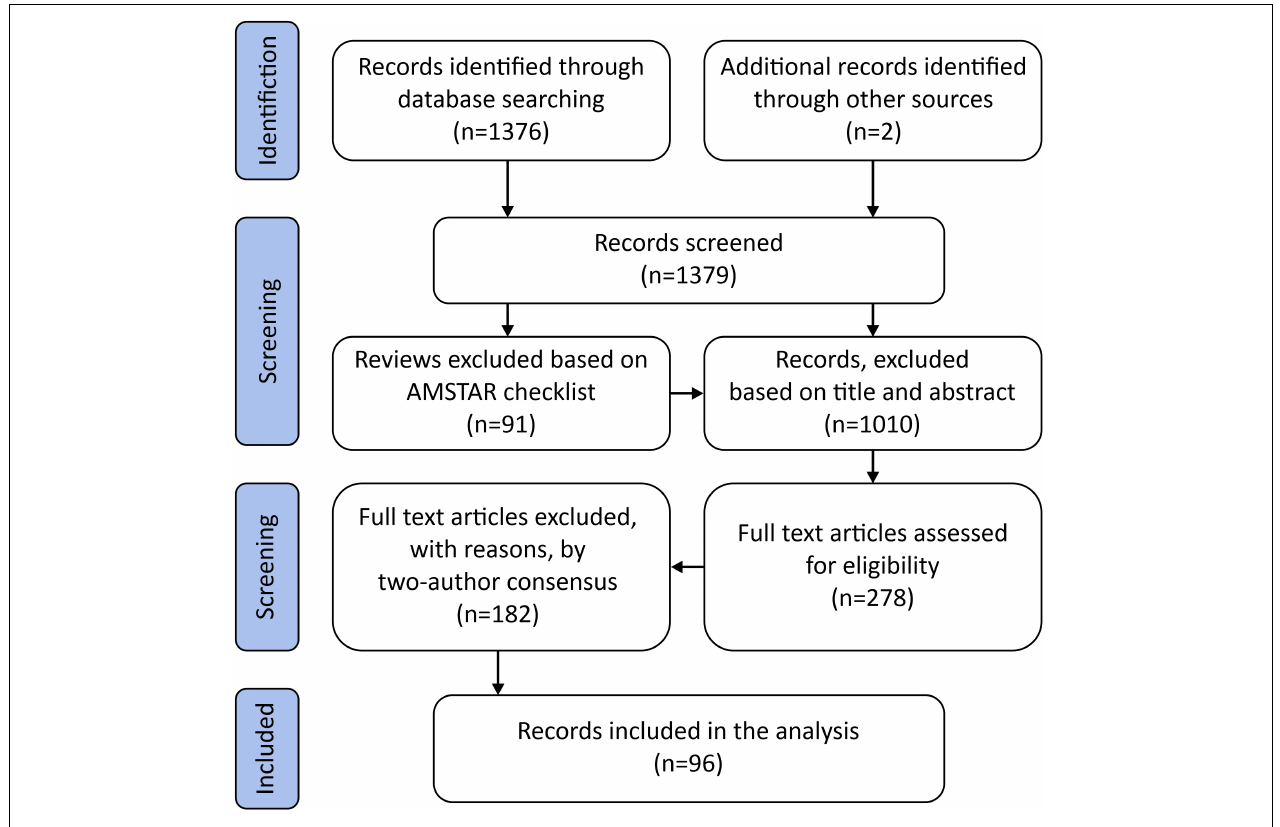
FIGURE 1 | PRISMA flow